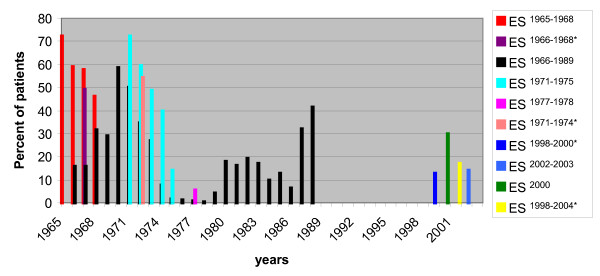
Percentage of meningiococcal meningitis cases based on studies conducted over 39 years. Nine different studies were conducted on patients diagnosed with meningitis due to N. meningitids from 1965-2004. Between 1966-1989, meningococcal meningitis cases caused by serogroup A are only presented. In ES1965-1968conducted on 644 cases of ABM, it was reported that meningococcus was responsible for 56% of bacterial meningitis cases [5]. In ES1966-1968on 187 patients, N. meningitidis was responsible for 49% of 123 culture positive cases and again identified as the leading cause of bacterial meningitis [6]. The prospective study ES1966-1989 on 7,809 patients also reported that 54% of meningitis cases were caused by N. meningitidis [23]. A retrospective study ES1971-1975 done on 1,333 patients reported that 56% of the cases were due to N. meningitidis infection [3]. ES1971-1974, on 783 patients reported that 54.4% (426) of the meningitis cases were due to meningococcal infection [14]. ES1977-1978 on 1627 CSF specimen demonstrated that N. meningitidis was the second most common bacterial meningitis (25.4% of the 350 bacterial meningitis cases) [10]. In the ES1998-2000 on 2047 children less than 6 years, N. meningitidis was reported to be responsible for 13% of the 228 bacterial meningitis cases [4]. The ES2000 identified N. meningitidis as the second leading cause of bacterial meningitis in Egypt responsible for 30% of the 223 patients positive culture [1]. Prospective study ES2002-2003 on 310 children clinically diagnosed with meningitis detected N. meningitidis in 14.2% of the cases and documented it as the second leading cause [21]. ES1998-2004 placed N. meningitidis as the third cause of bacterial meningitis [2]. The asterisks represent epidemiological studies reporting an average during the entire period of the study.